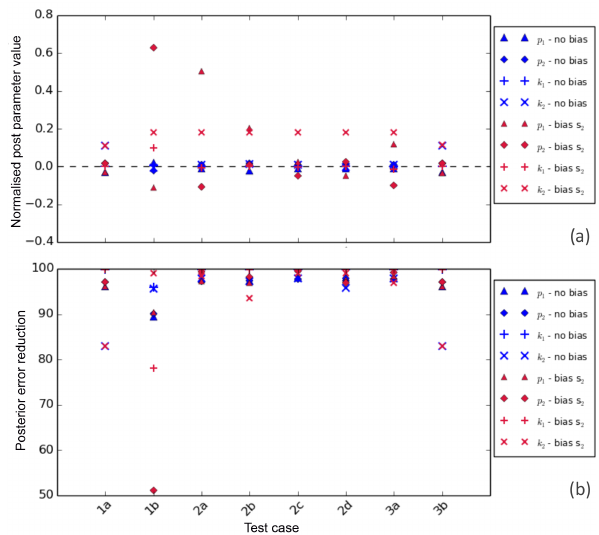
Figure 2. (a) Normalised posterior parameter values and (b) poste- rior parameter error reduction for all parameters of the simple car- bon model for each test case, and for both the simulations with no bias (blue) and simulations with a bias in the s 2 variable that was not accounted for in the inversion (red). In (a) parameter values were normalised to account for differences in the magnitude of the different parameters and their range; thus it is a measure of the dis- tance from the true value as a fraction of the range and is calculated as (posterior value − true value / max parameter value − minimum parameter value). The closer the value is to the zero dashed line, the closer the posterior value is to the “true” parameter value. To give an indication of the optimisation performance, the following are the normalised first-guess parameter values for this particular example test (compare with posterior values in a ): p 1 0.09, p 2 0.29, k 1 0.1, k 2